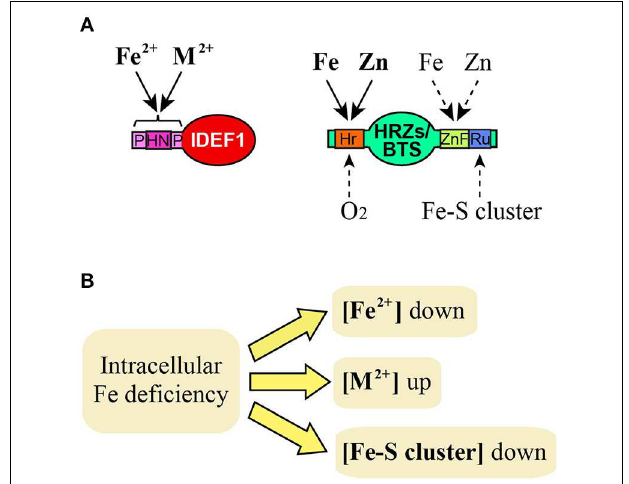
FIGURE 1 | Possible Fe signals recognized by IDEF1 and HRZs/BTS. (A) Known or putative binding of Fe and related molecules to domains of IDEF1 and HRZs/BTS. Solid and broken lines indicate known and putative bindings, respectively. M 2 + , divalent metal ions such as Zn, copper and nickel. HN, histidine-asparagine repeat; P, proline-rich region; Hr, hemerythrin domains; ZnF, Zn finger domains; Ru, rubredoxin-type fold. (B) Deduced effects of intracellular Fe deficiency on concentrations of Fe and related molecules which may act as Fe